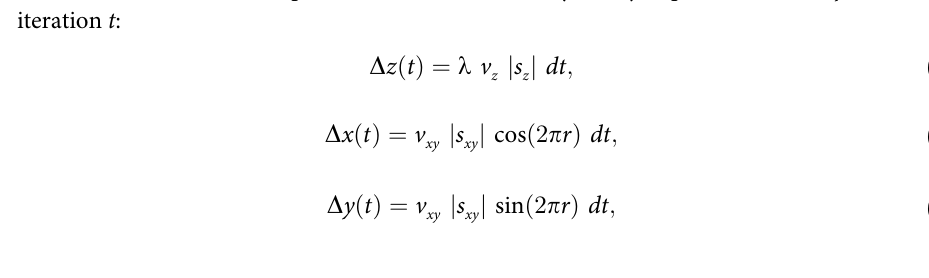
Fig 3. Data from Impact-R device. The data collected from Impact-R for a healthy volunteer containing three observed quantities N ð t Þ are correspondingly average size of the aggregation clusters, their number per mm 2 and the number of non-activated platelets per μℓ still in suspension at N platelet time t